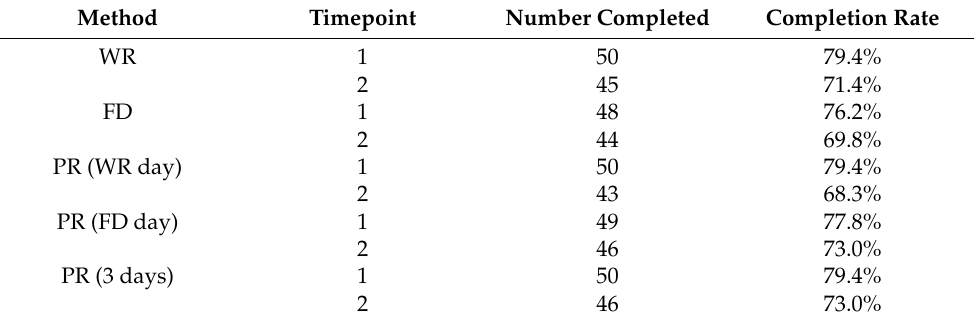
Table A1. Number and percent of participants who completed the different assessment